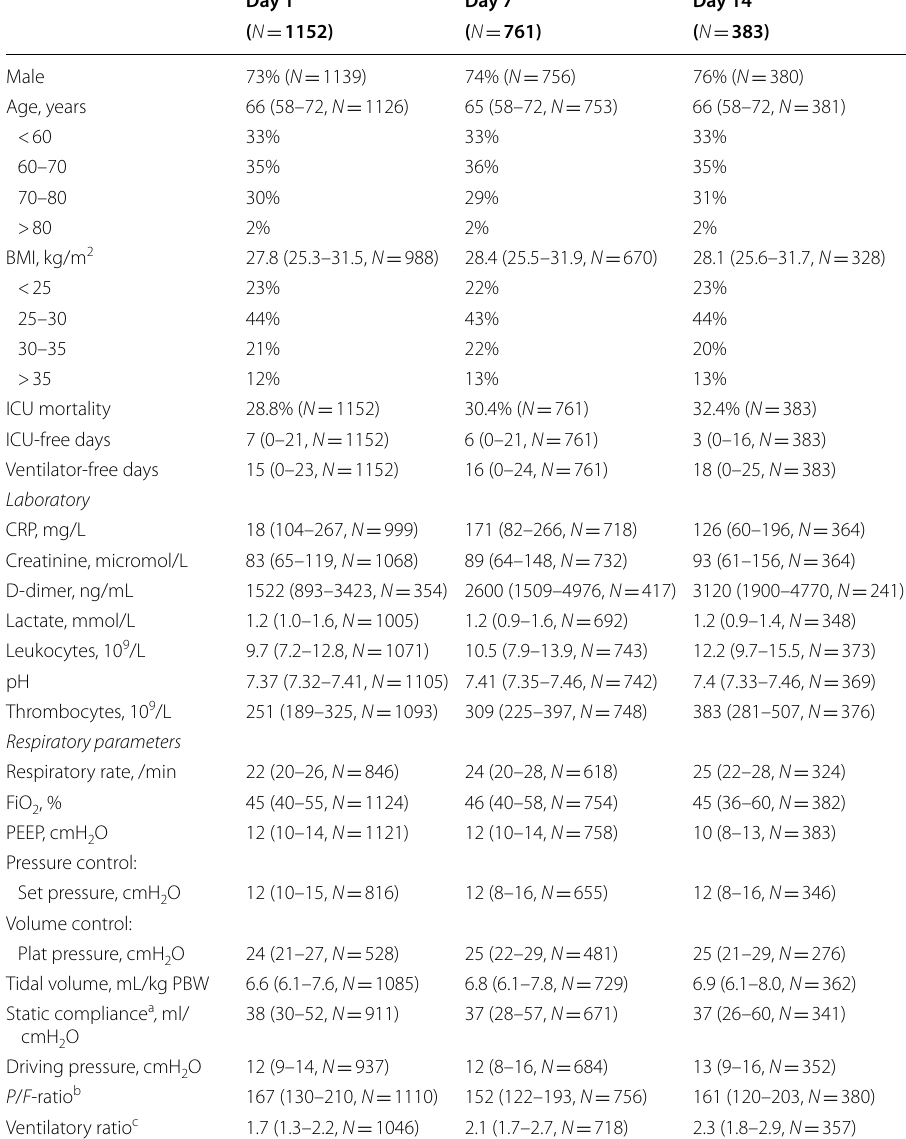
Table 1 Patient characteristics on day 1, day 7 and day 14 of invasive mechanical